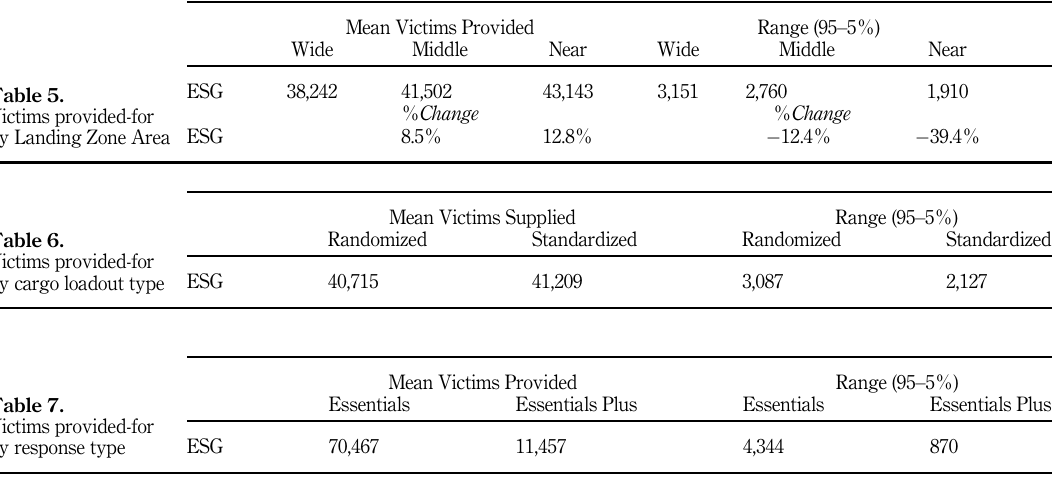
Table 5. Victims provided-for by Landing Zone Area